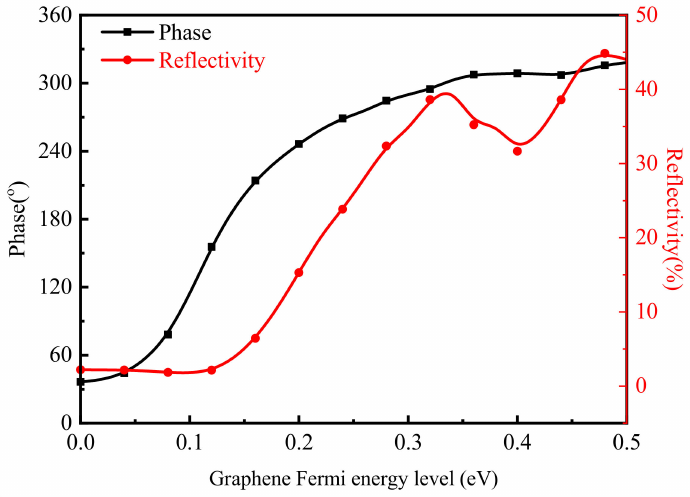
Figure 3. The changing trend of reflection phase and amplitude with various Fermi levels of